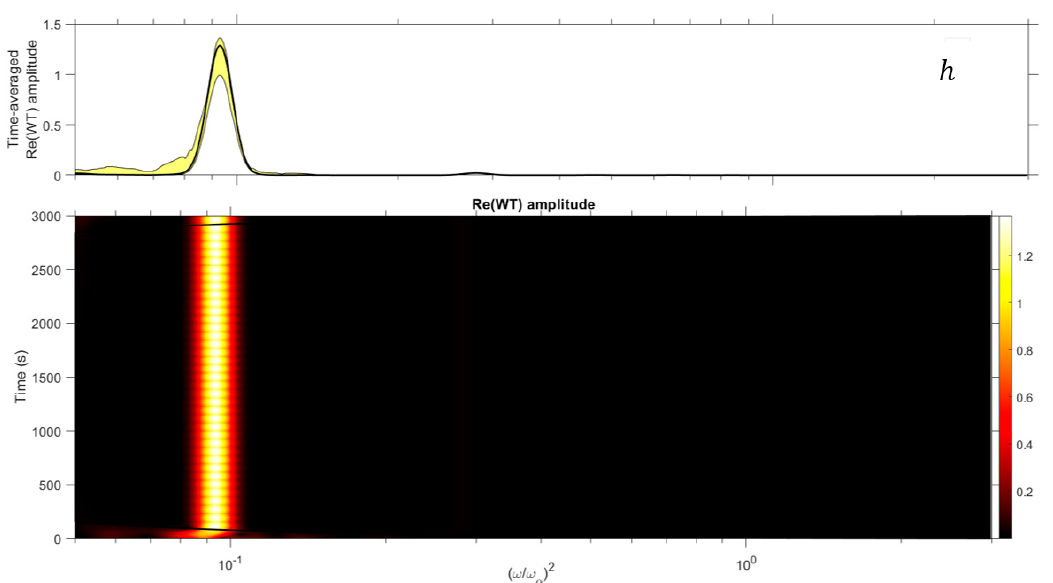
/ bending displacement Figure 6. Time–frequency analysis of the plunge/bending displacement signal. Figure 6. Time–frequency analysis of the plunge Figure 6. Time–frequency analysis of the plunge/bending displacement signal.